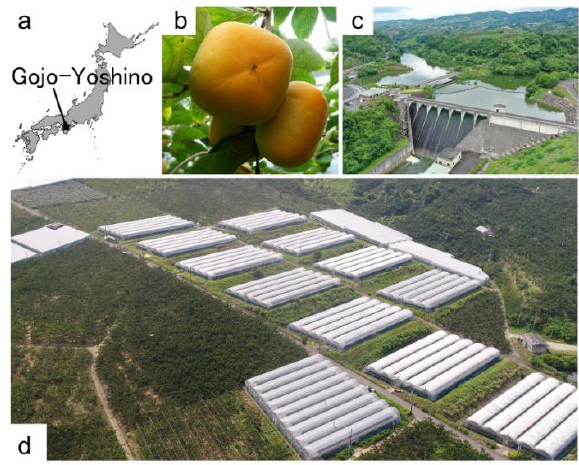
Figure 1. Study area and view of persimmon cultivation. ( a ) Location of Gojo-Yoshino region; ( b ) Image of major persimmon grown in Gojo-Yoshino region, ‘Tone Wase’; ( c ) Ichinomi Dam for irrigation; and ( d ) Greenhouses and on-field persimmon cultivation areas.